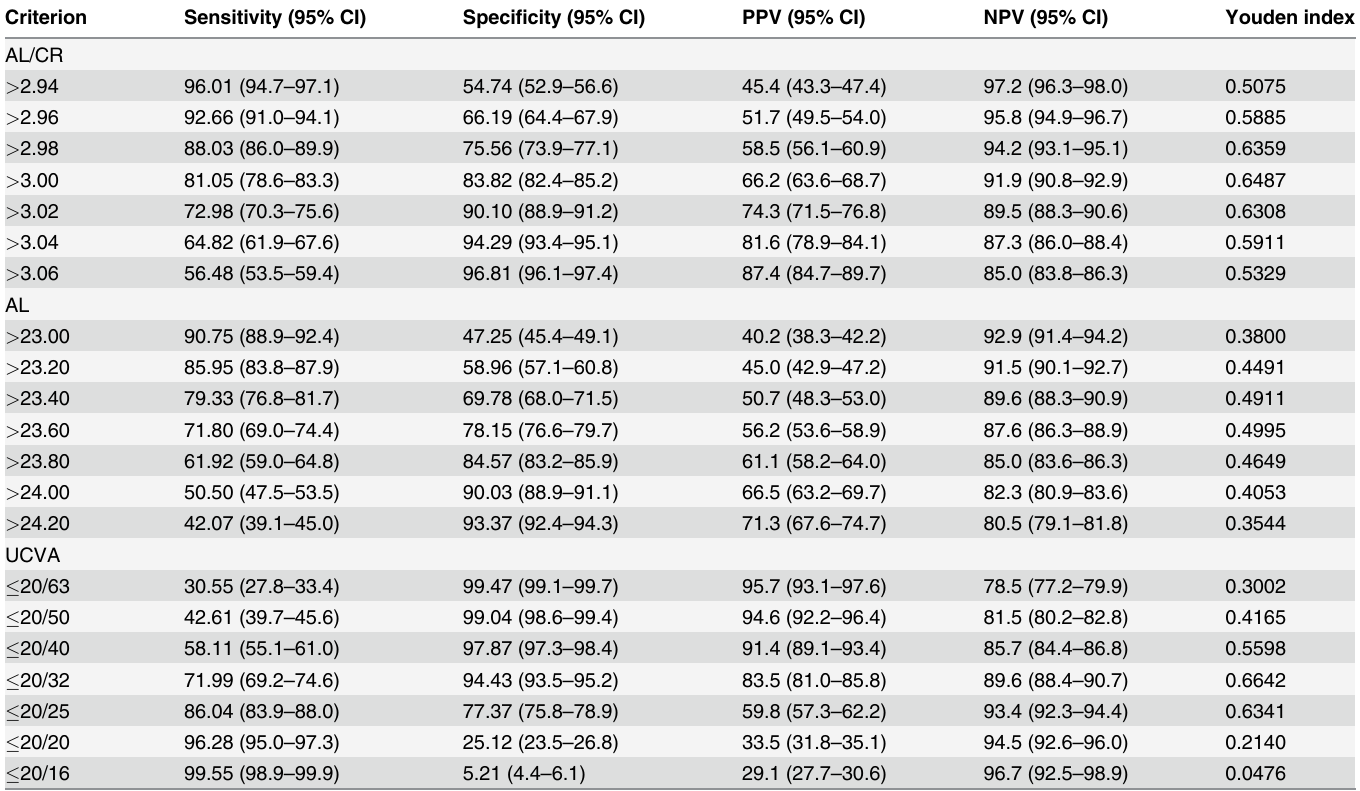
Table 5. Sensitivity, speci fi city, PPV, NPV, 95% CI, and Youden Index of UCVA, AL, and AL/CR of screening of schoolchildren for myopia. Criterion